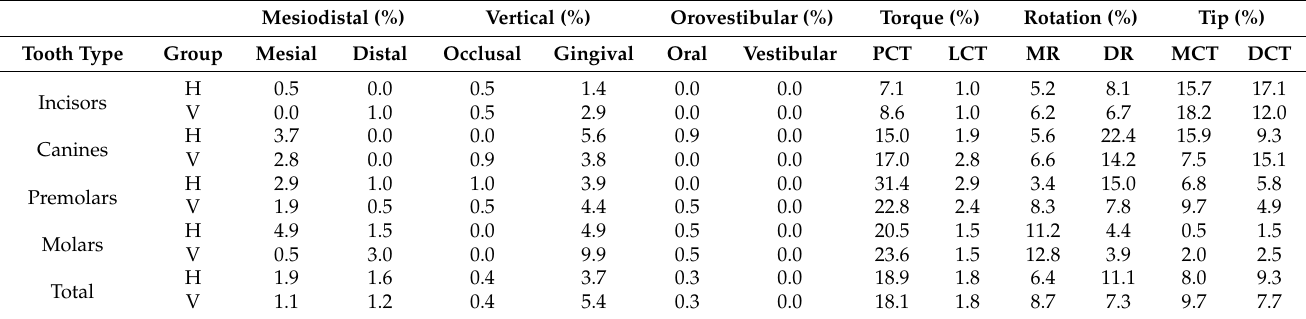
Table 3. Prevalence of bracket transfers outside of the clinically acceptable range in Group H and V for different tooth